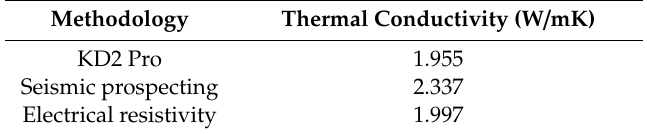
Table 6. Thermal conductivity results of each method considered in this